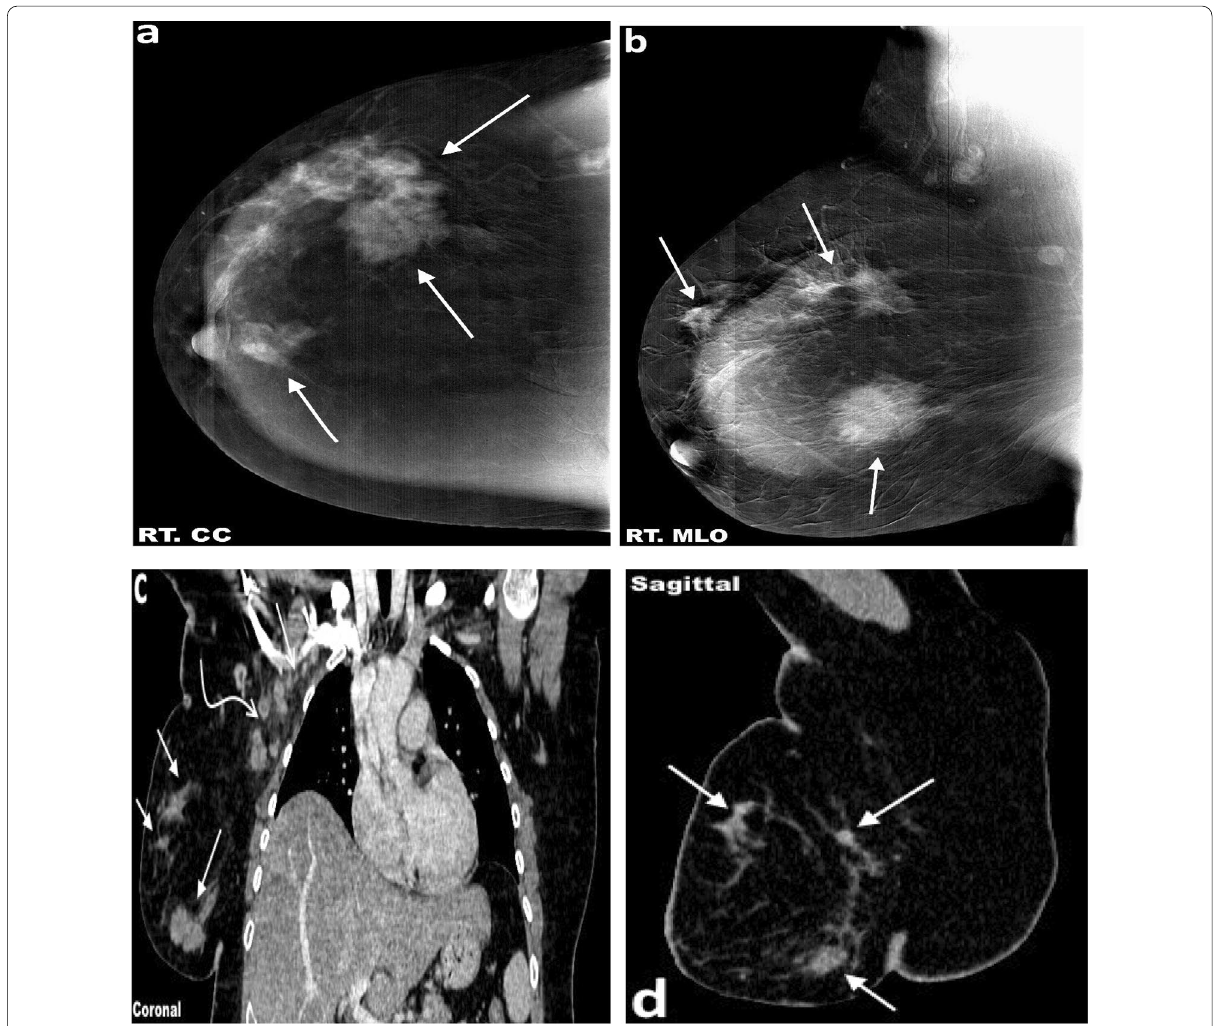
Fig. 1 A 40‑year‑old female patient complained of a right breast lump. CESM of right breast CC and MLO views ( a , b ) and contrast‑enhanced CT chest coronal and sagittal planes ( c , d ) showed right breast multiple spiculated heterogeneously enhancing masses (straight arrows) (occupying UOQ and LOQ) (i.e., multicentric masses), pathologically proven invasive ductal carcinoma, grade II with multiple pathologically enlarged right axillary lymph nodes (level I, II, III) best demonstrated on coronal images (curved arrow). The histopathology result was IDC grade